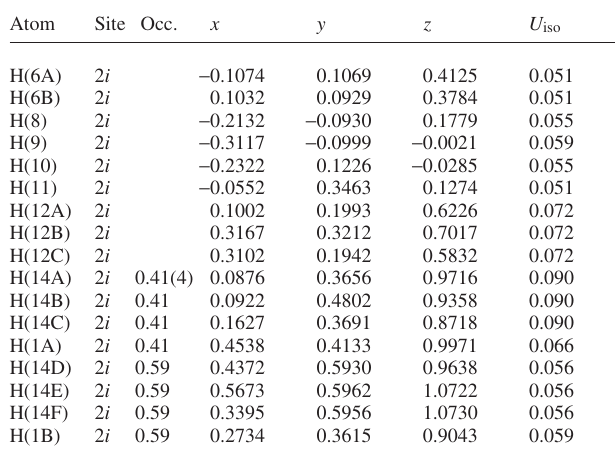
Table 1. Data collection and